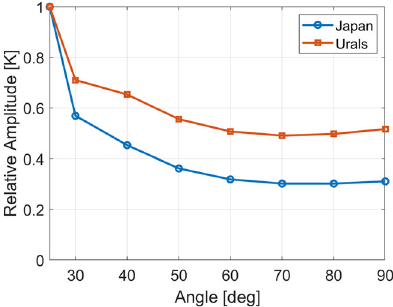
Fig. 5 Reduction in recovered amplitudes relative to 25° case. Figure shows average GW amplitudes over the regions de fi ned by black boxes in Figs. 3 (orange line) and 4 (blue line), as computed from brightness temperature estimates over a range of viewing